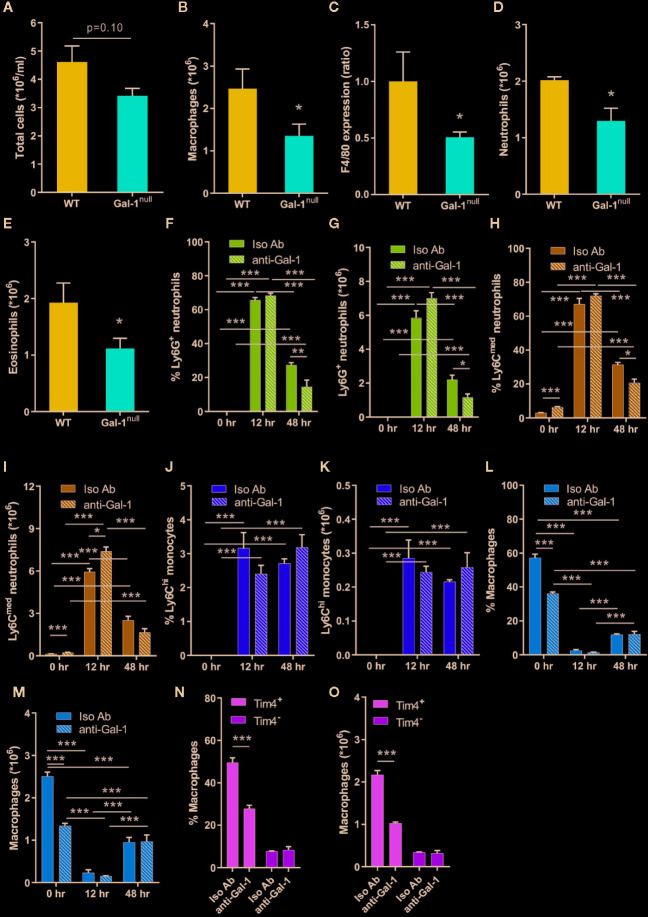
Gal-1 increases the numbers of peritoneal neutrophils, eosinophils, and macrophages. (A–E) Peritoneal exudates were collected from WT and Gal-1null male mice 48 h PPI. Peritoneal leukocytes were enumerated, immunostained for Gr-1, F4/80, and CD11b, and analyzed by flow cytometry, n = 6–10. (A) The number of peritoneal leukocytes/ml in peritoneal fluids. (B) The total number of macrophages. (C) The ratio of F4/80 expression, based on MFI. (D) The total number of neutrophils. (E) The total number of eosinophils. (F–O) 12 to 24 h prior to peritoneal cell collection mice were administered with neutralizing anti-Gal-1 mAb (anti-Gal-1) or isotype IgG (Iso Ab). Peritoneal cells were collected from unchallenged mice, or at 12 or 48 h PPI. Upon recovery, peritoneal leukocytes were enumerated, immunostained for the surface antigens Ly6G, Ly6C, F4/80, and Tim4, and analyzed by flow cytometry. Eosinophils were gated out due to unspecific binding of 2nd antibody to anti-Gal-1 mAb, which was performed concomitantly. Leukocytes are presented in percentage (F, H, J, L, N) or in total numbers/ml (G, I, K, M, O) in peritoneal fluids, n = 4. Measurements of the following leukocyte populations: Ly6G+F4/80- neutrophils (F, G), Ly6CmedF4/80- neutrophils (H-I), Ly6ChiF4/80- monocytes (J, K), F4/80+Ly6C- macrophages (L, M), F4/80+Tim4- monocyte-derived resident macrophages and F4/80+Tim4+ yolk sac-originated resident macrophages (N, O). Altogether, the data represent at least two independent experiments and are presented as mean ± SEM. Statistical analysis by two-tailed Student's t-test; *p < 0.05, **p < 0.01, ***p < 0.001.